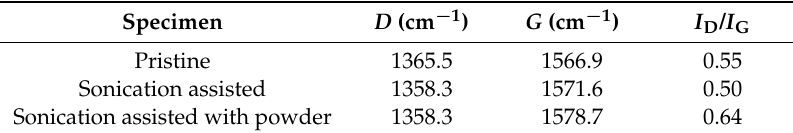
Table 6. The positions of D and G bands, and the I D / I G .